Question: Sum up the contents of this chart in one sentence.
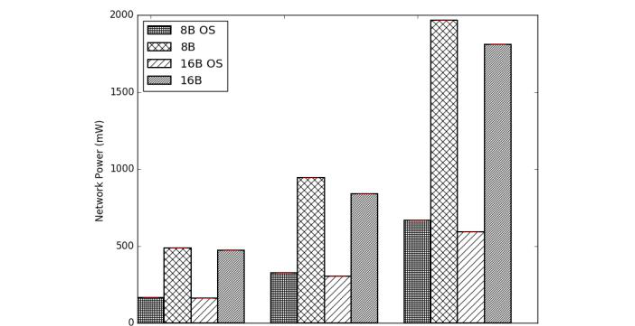
Answer: Power required processing an epoch with four out- scaling zones compared with no out-scaling with 8 to 16-byte